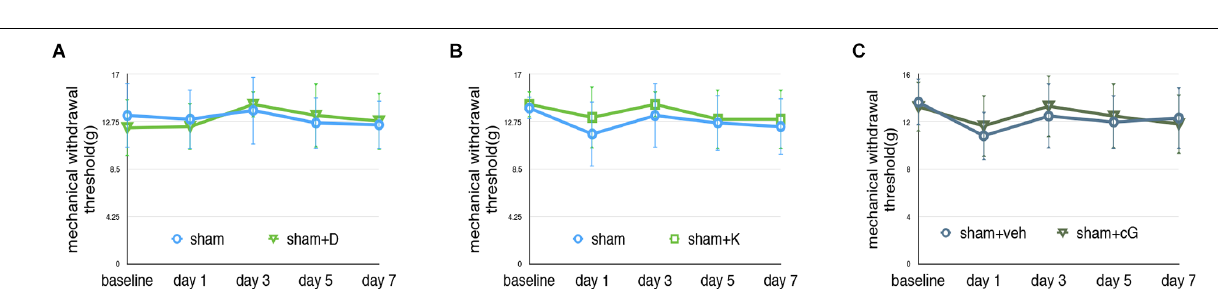
Frontiers in Synaptic Neuroscience |